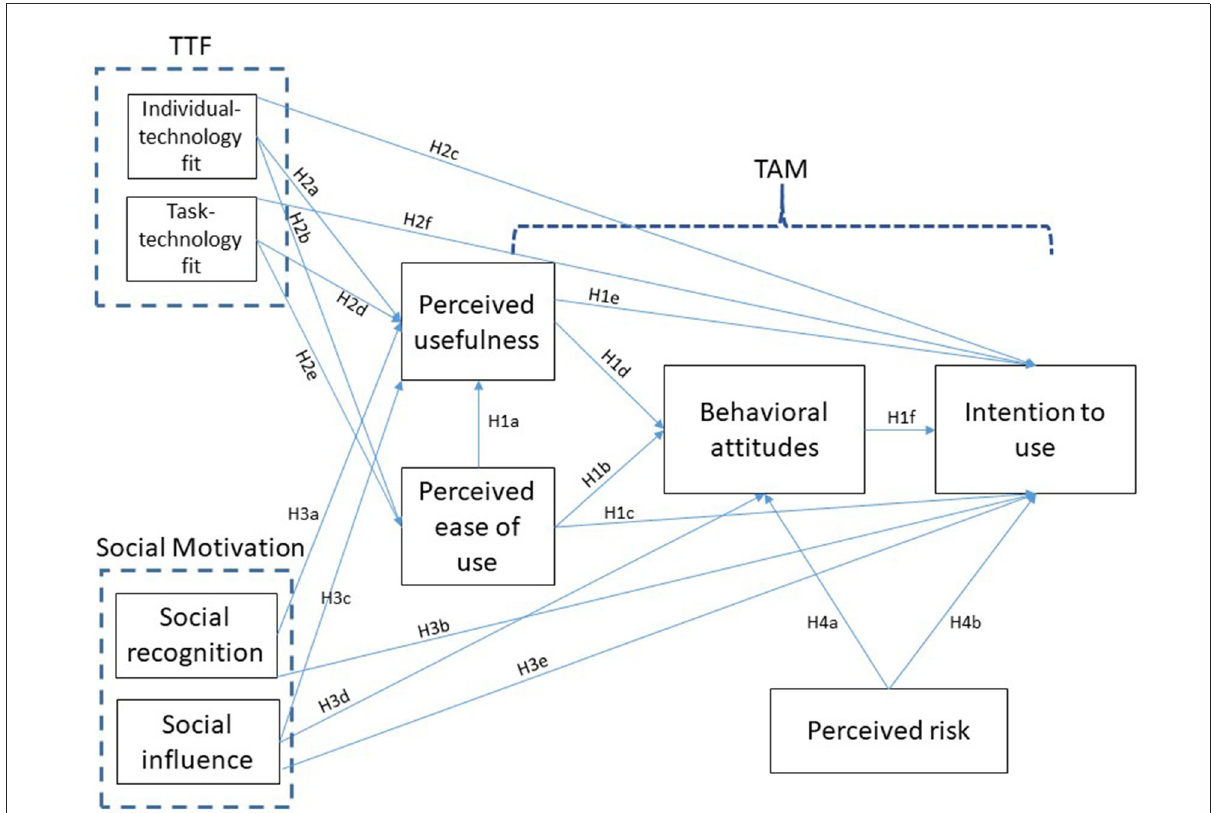
FIGURE1 Proposed research